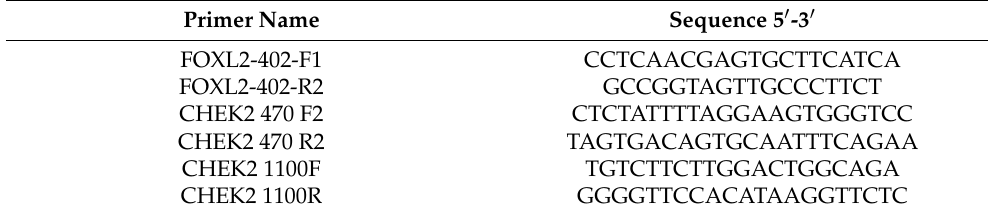
Table A1. Primers used for PCR amplification and sequencing of the FOXL2 and CHEK2